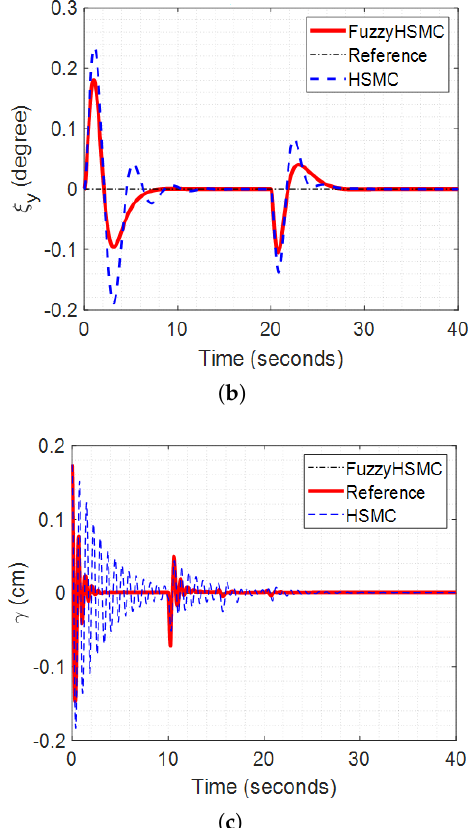
Figure 7. The under-actuated states given the step input. ( a ) The sway of the payload in Oxz , ξ x ( t ) . ( b ) The sway of the payload in Oyz , ξ y ( t ) . ( c ) The oscillation of the hoisting cable in the cable direction, γ ( t )